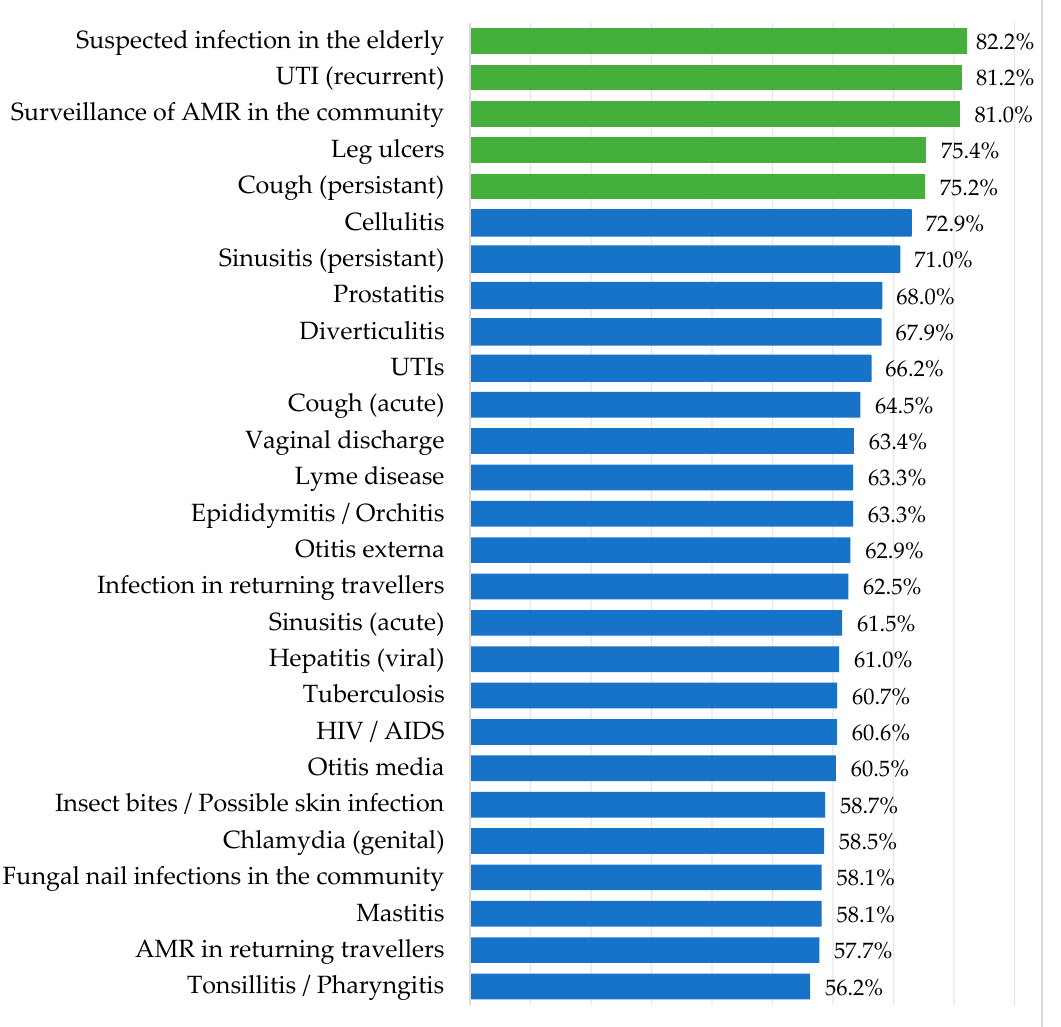
Figure 2. Condition ranking presented as a percentage of the total possible score for each condition. Condition ranking is the total scores for each illness (where 1 = further research unimportant, 5 = further research very important) were converted into a percentage by dividing the total score by the maximum possible score, i.e., as if all respondents indicated that further research into that illness was ‘very important’.